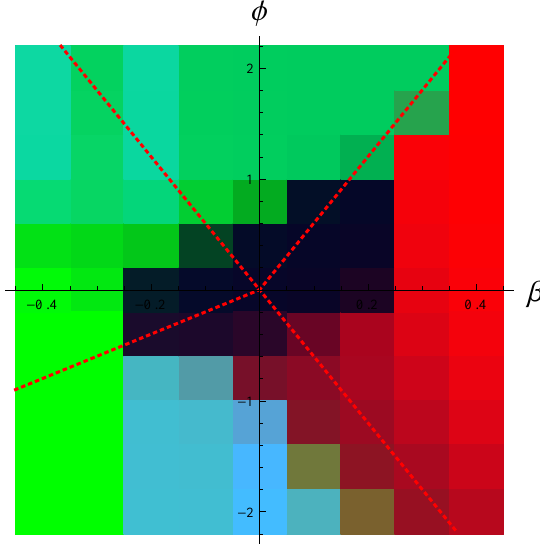
Figure 9: (Color online) Phase diagram on a 10 3 lattice using the “branch point” vertex resolution protocol. A color coding system has been used where red measures ferromagnetic order, green measures antiferromagnetic order, and blue measures the sum of O + and O − . The four distinct colors correspond to the following phases in Table 1: top (dark green) is plumber’s nightmare I, right (red) is ferromagnetic, bottom (blue) is packed, and left (bright green) is antiferromagnetic. The interior dark region is a paramagnetic phase. The “classical” phase boundaries – i.e. arising purely from minimizing the Hamiltonian – have been indicated with red dotted lines. This is topologically the same as the mean-field phase diagram in Fig. 7 but the phase boundaries have shifted